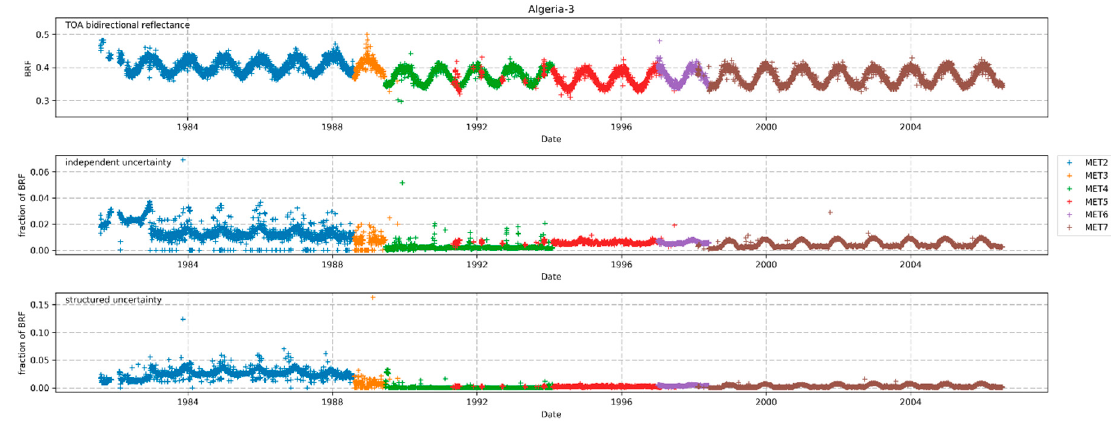
Figure 9. Harmonised MVIRI VIS fundamental climate data records (FCDR) time series of clear-sky reflectance at Algeria-3 along with structured and independent uncertainties. Trends and jumps are due to the changing SRFs. Alternating measurements from two satellites, as in 1992, are mostly due to a takeover by the backup satellite during maintenance operations of the primary satellite.